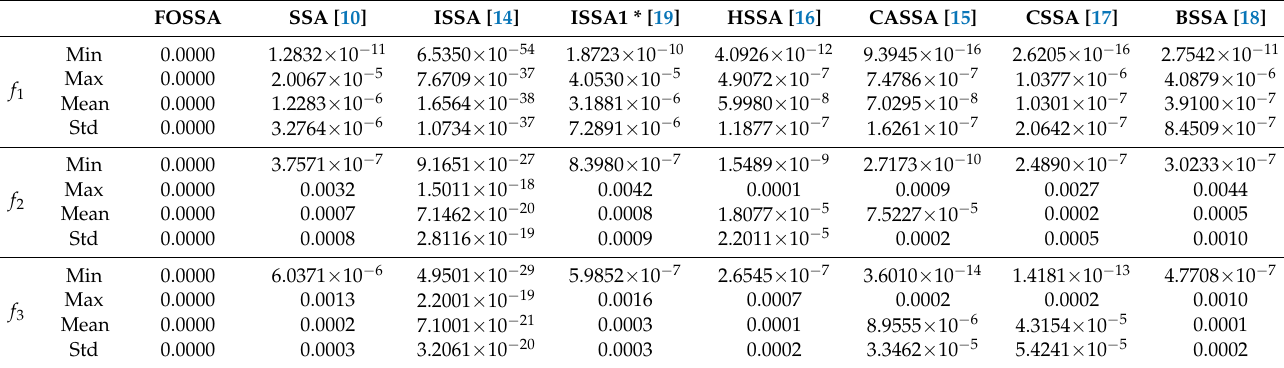
Table 2. Compared results of algorithms for unimodal